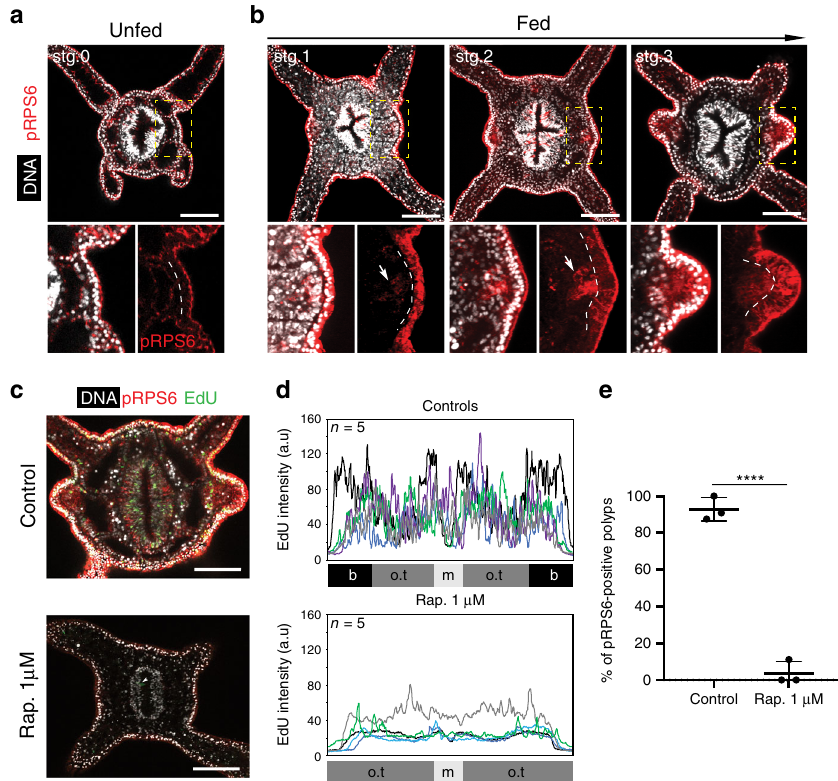
Fig. 5 TOR pathway is required for growth and tentacle budding in fed polyps. a Confocal z -section of the oral pole of unfed polyp stained with with an antibody against pRPS6 (red) and Hoechst to label nuclei (white) in four independent experiments ( n = 28 polyps). Inset box is a zoom in of the segment 3. b Confocal sections of developing buds at sequential stages ( n = 32 polyps). Inset boxes show a higher magni fi cation of segment 3 for each stage. Dashed lines separate the outer- and inner-layer nuclei. Arrows indicate the enrichment of pRPS6 in the inner-layer of tentacle primordia. c Confocal projection of the oral pole of 5 days fed control and 8 days fed rapamycin-treated polyps stained for EdU incorporation (green), an antibody against pRPS6 (red) and with Hoechst (white; three independent experiments). White arrowhead indicates an unspeci fi c EdU-labeling in the pharynx. d Plots of EdU intensity in control polyps ( n = 5) and rapamycin-treated polyps ( n = 5). Scale bars are 50 μ m . e Quanti fi cation of polyps showing PS6RP-postive tentacle primordia in control polyps ( n = 25) and rapamycin-treated polyps ( n = 26). Data are mean ± SD for error bars (unpaired Student ’ s two-tailed t -test, **** p < 0.0001). Source data are provided as a Source data fi